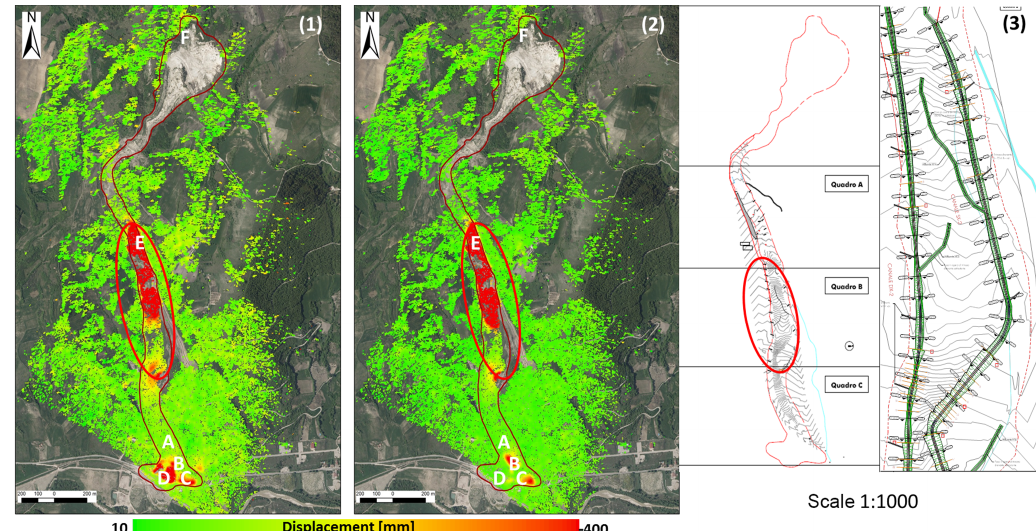
Figure 14. Monthly cumulated maps for March (1) and April (2) 2012 showing the interferometric evidence of the deformation phenomena affecting the E sector and the subsequent design variant (3) .